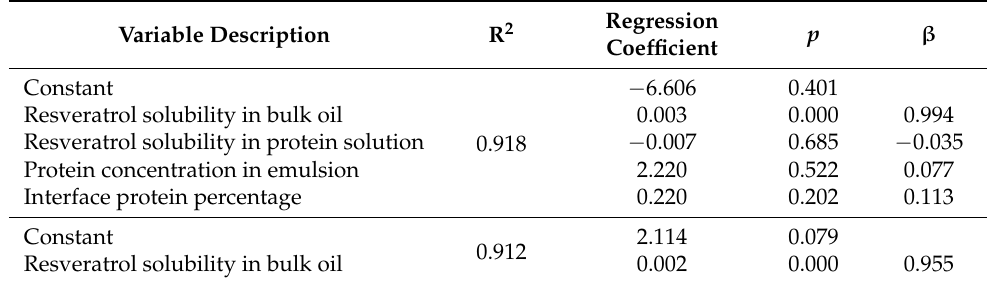
Table 4. Multiple linear regression analysis of the percentages of resveratrol in the oil phase of sunflower oil, MCT and peppermint oil